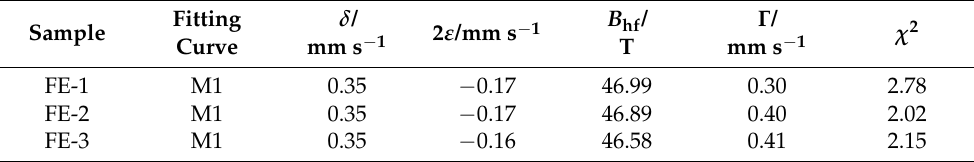
Table 1. 57 Fe Mössbauer parameters of samples FE-1, FE-2 and FE-3 recorded at 20 ◦ C. Sample